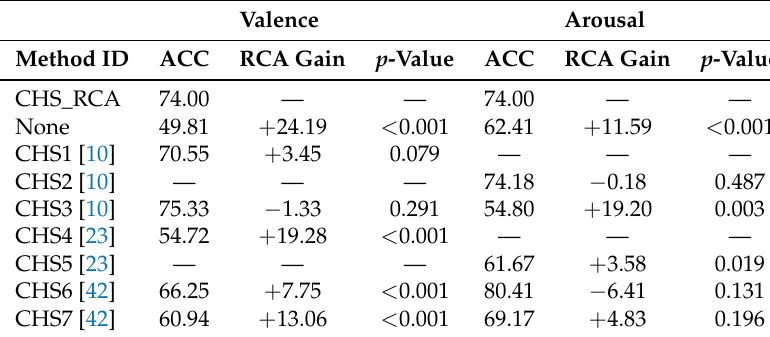
Table 4. Results of classification accuracy [in